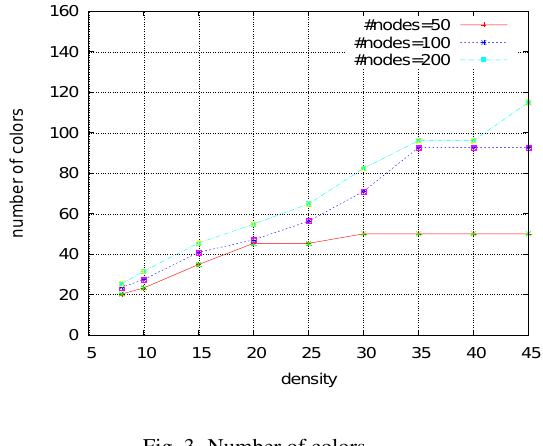
Fig. 3. Number of colors.